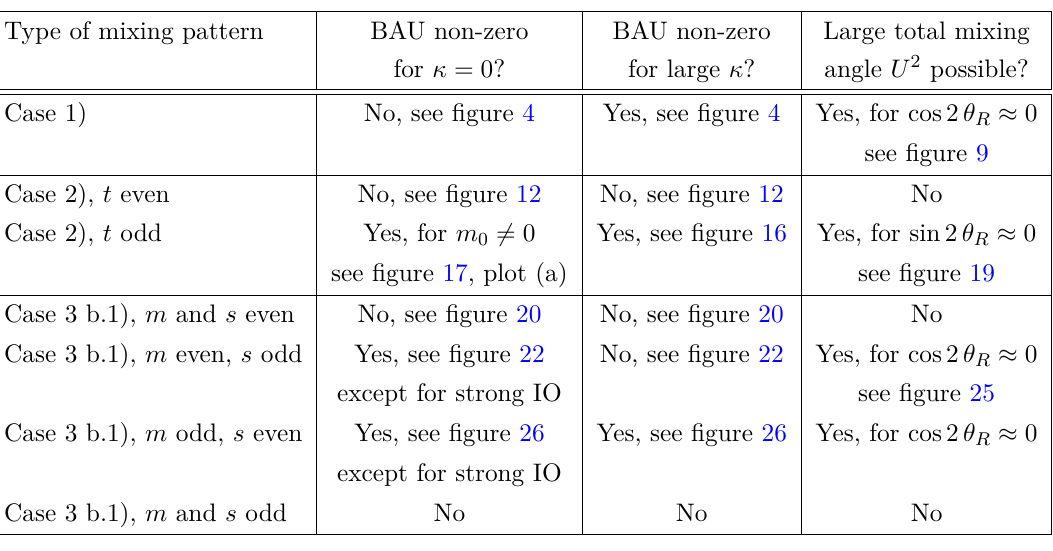
Table 6 . Overview over results for the different cases , related to different mixing patterns for leptons. We highlight whether or not it is possible to generate a non-zero value of the BAU for vanishing splitting κ (and λ ), whether or not we obtain a non-zero value of the BAU for large values of κ , κ (cid:29) Γ /M , and if it is possible to simultaneously have large total mixing angle U 2 and generate the observed amount of